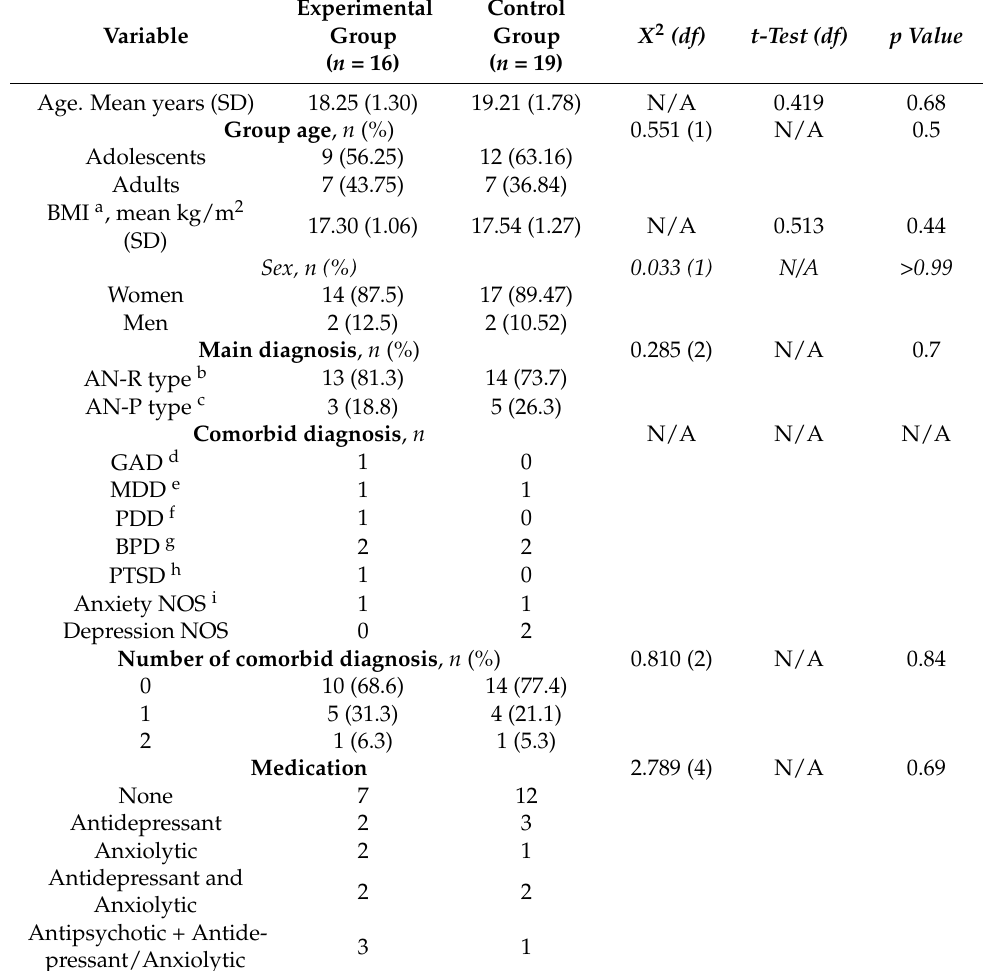
Table 1. Descriptive results, including the demographic and clinical characteristics of both groups.